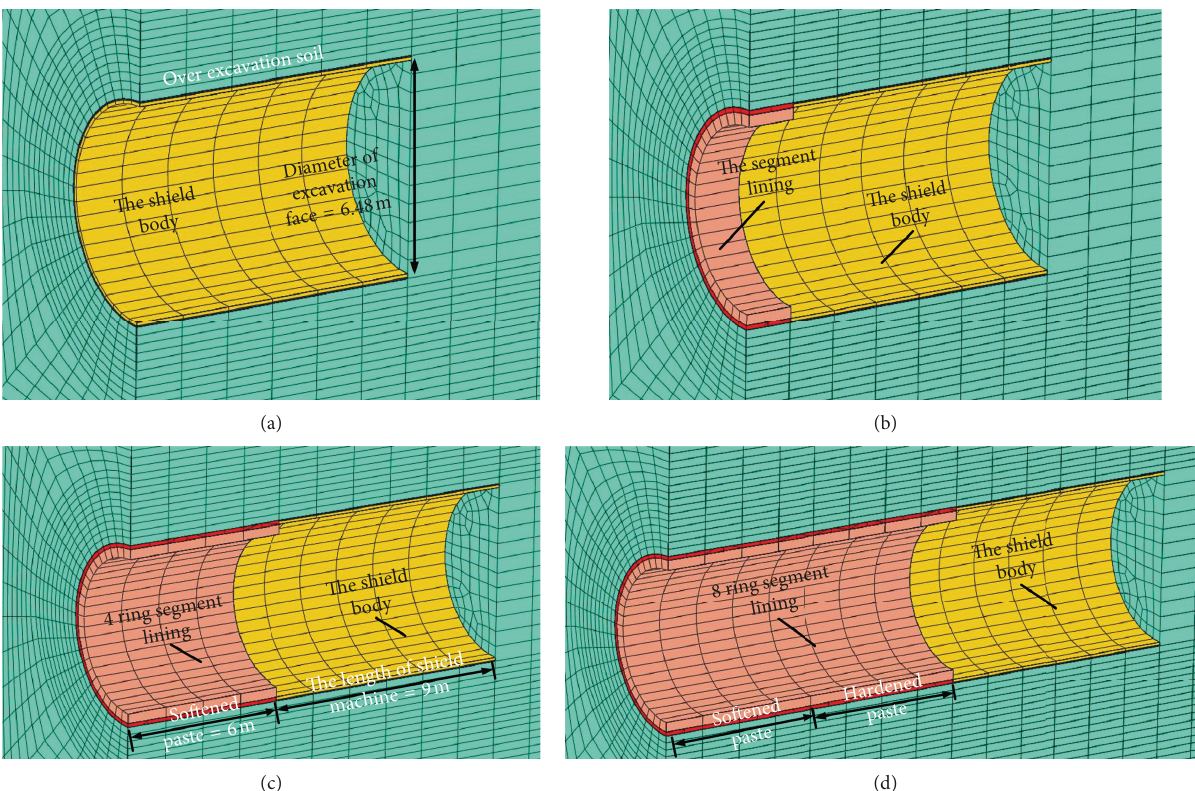
Figure 8: Numerical simulation of shield tunnel excavation. (a) Shield machine body enters the soil, (b) segment and tail grouting, (c) segment and tail grouting, and (d) segment and hardened